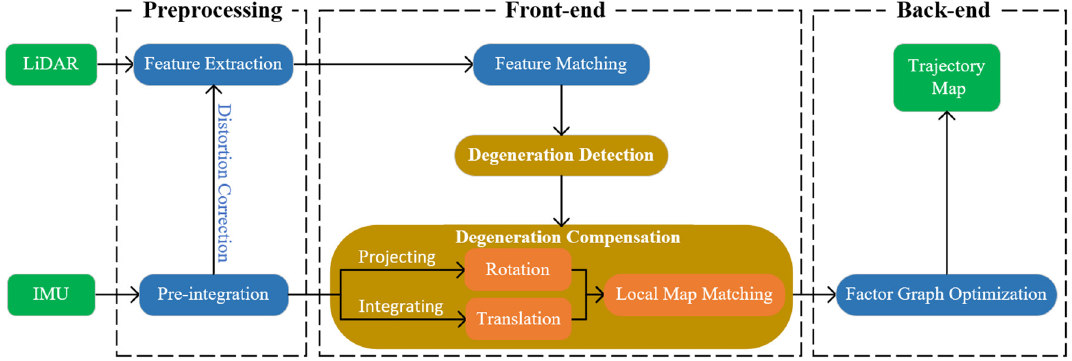
Figure 2. Schematic diagram of the proposed method.